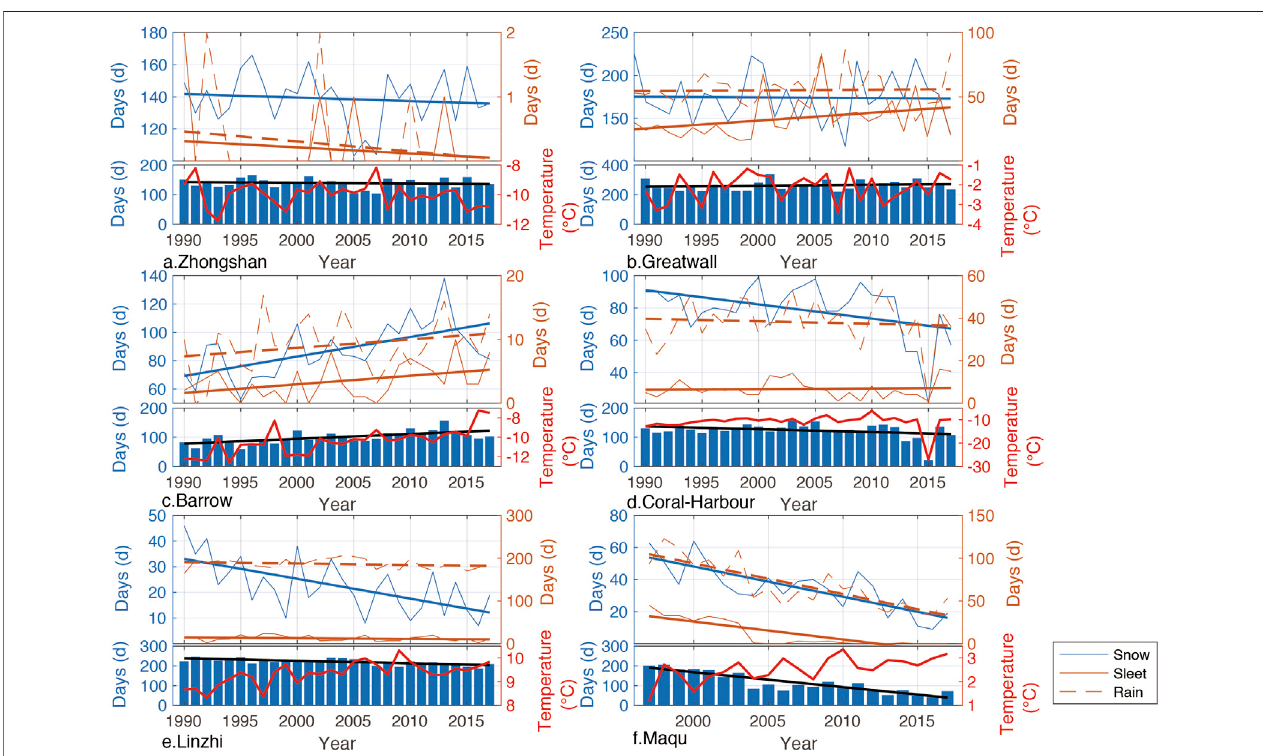
FIGURE 4 | Variations in the annual rain, sleet, snow, and total precipitation days and their linear trend (bold line) at the Zhongshan, Greatwall, Barrow, Coral Harbour, Linzhi and Maqu stations (a – e: 1990 – 2017; f: 1997 – 2017, red bold lines are the annual mean air temperature curves).